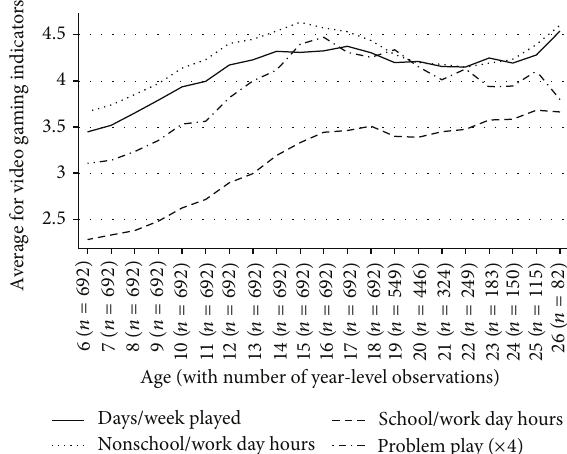
Figure 1: Trends in video gaming variables through the early life course. All curves were significantly quadratic in analyses that did not include control